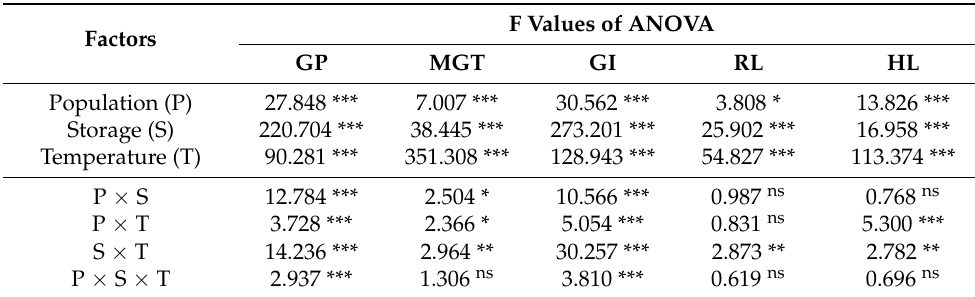
Table 1. Three-way ANOVA results of germination percentage (GP), mean germination time (MGT), germination index (GI), radicle length (RL), and hypocotyl length (HL).